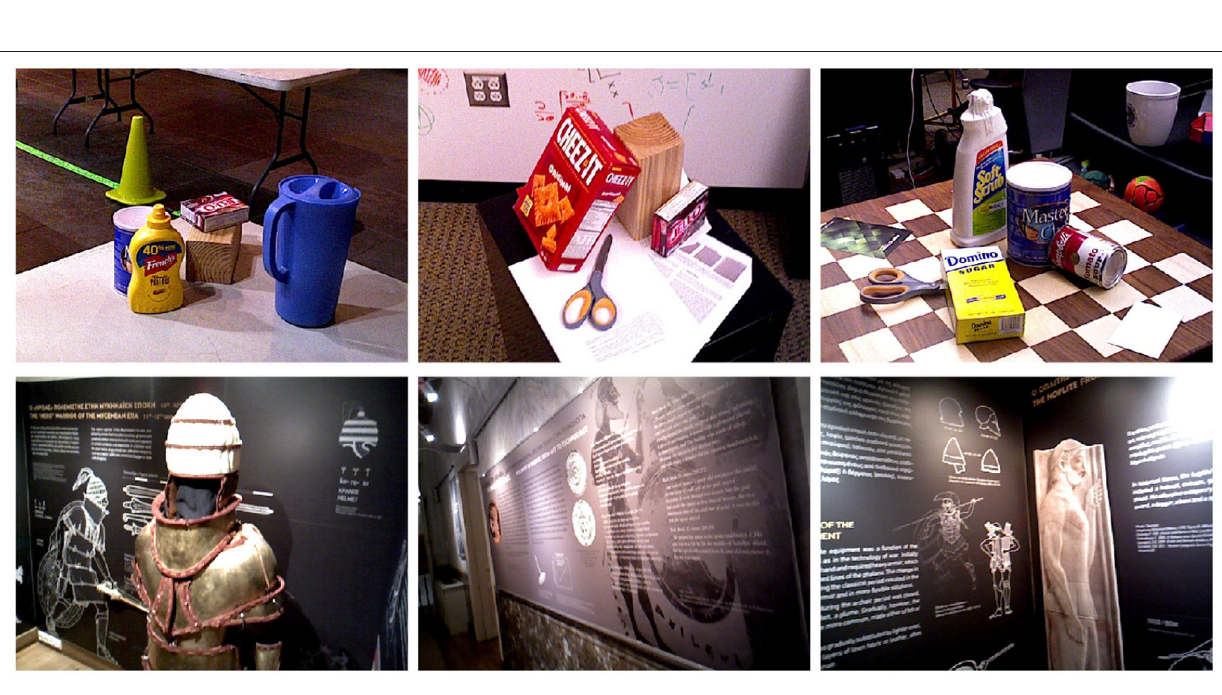
We split the frames of each sequence into a training and a validation